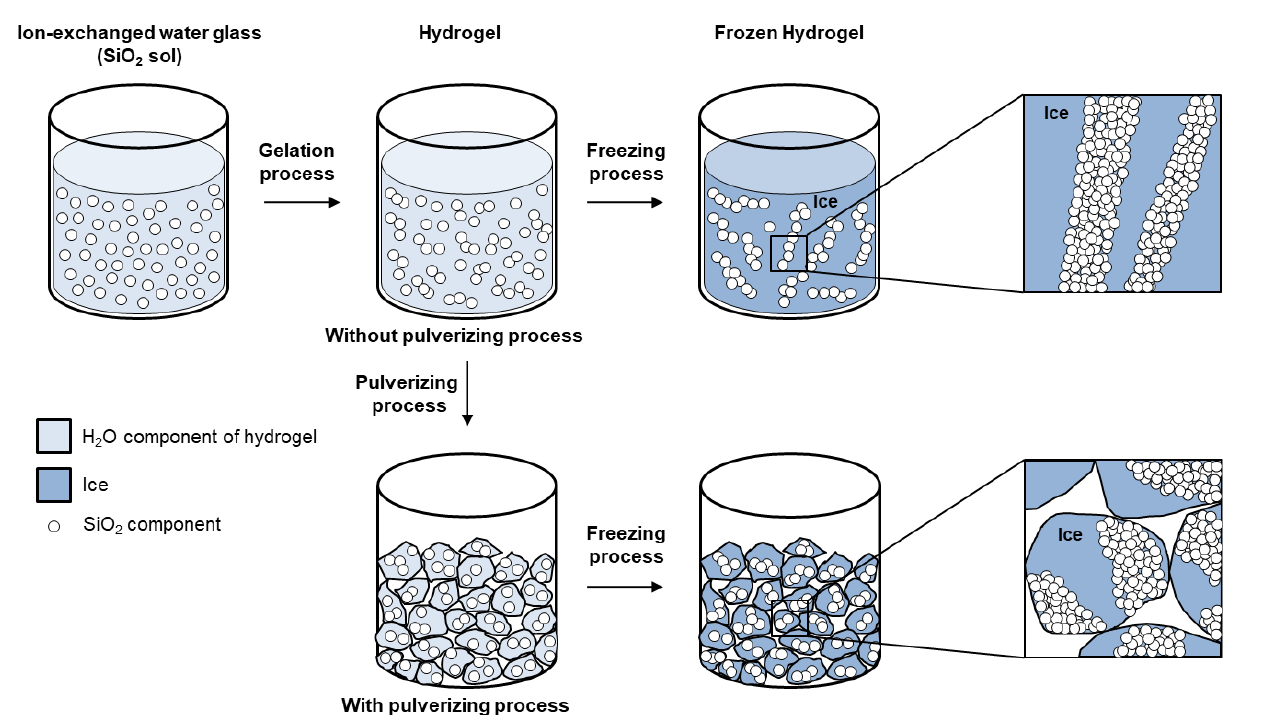
Figure 4. Schematic model of forming morphology of as-synthesized quartz powder.